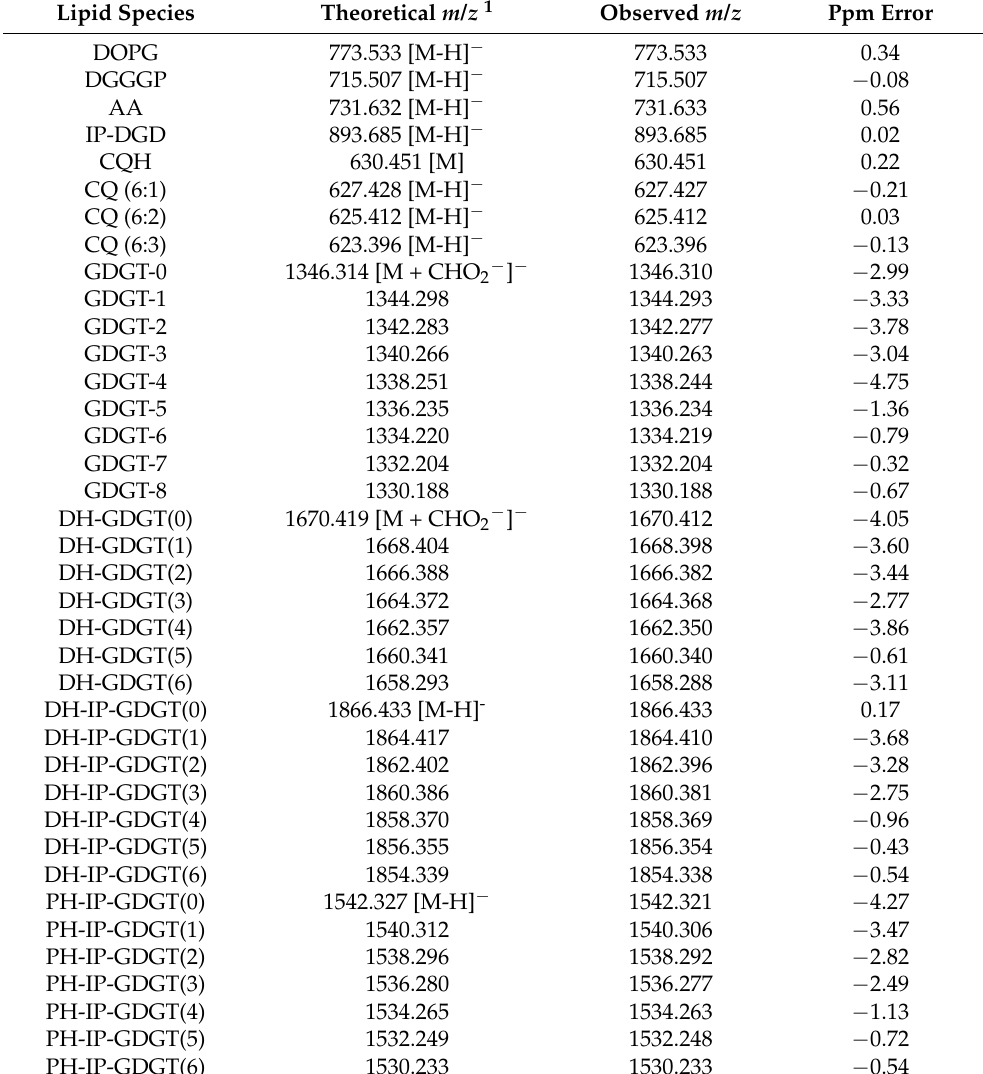
Table 1. Ppm error of the lipid species observed in this